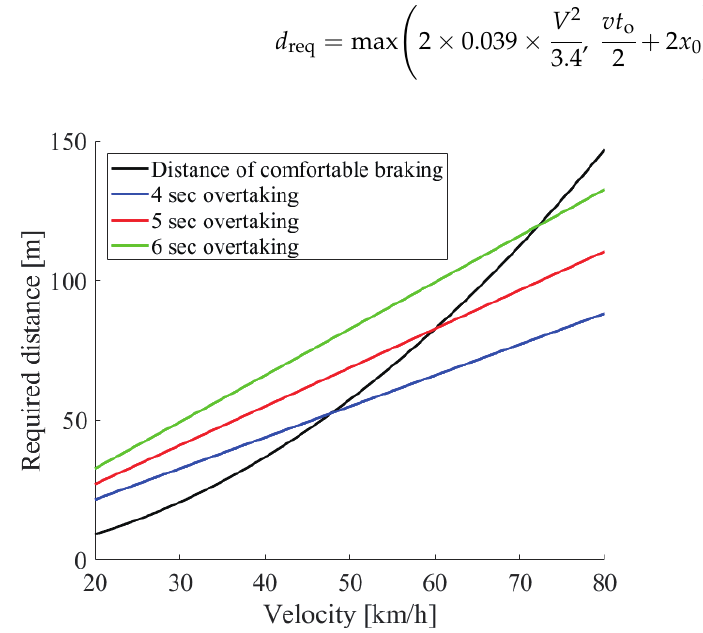
Figure 7. The distance required for the driving path and comfortable